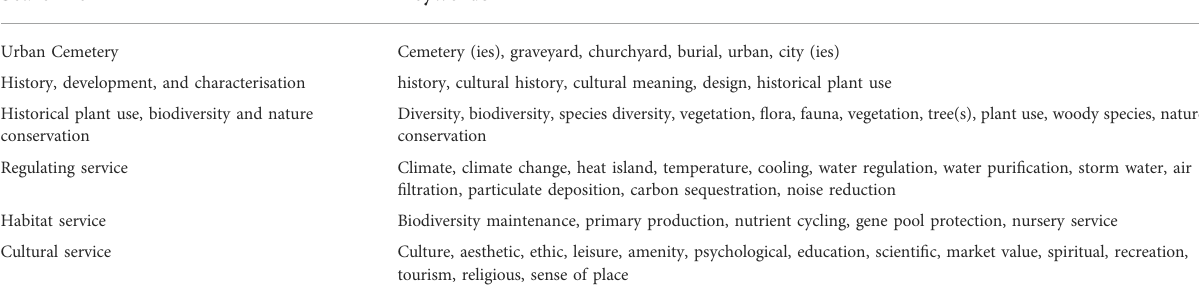
TABLE 1 Keywords relating to cemeteries and outcome-related key words for history, development, and characterisation, biodiversity as well as regulating, provisioning, habitat, and cultural services of cemeteries. Search